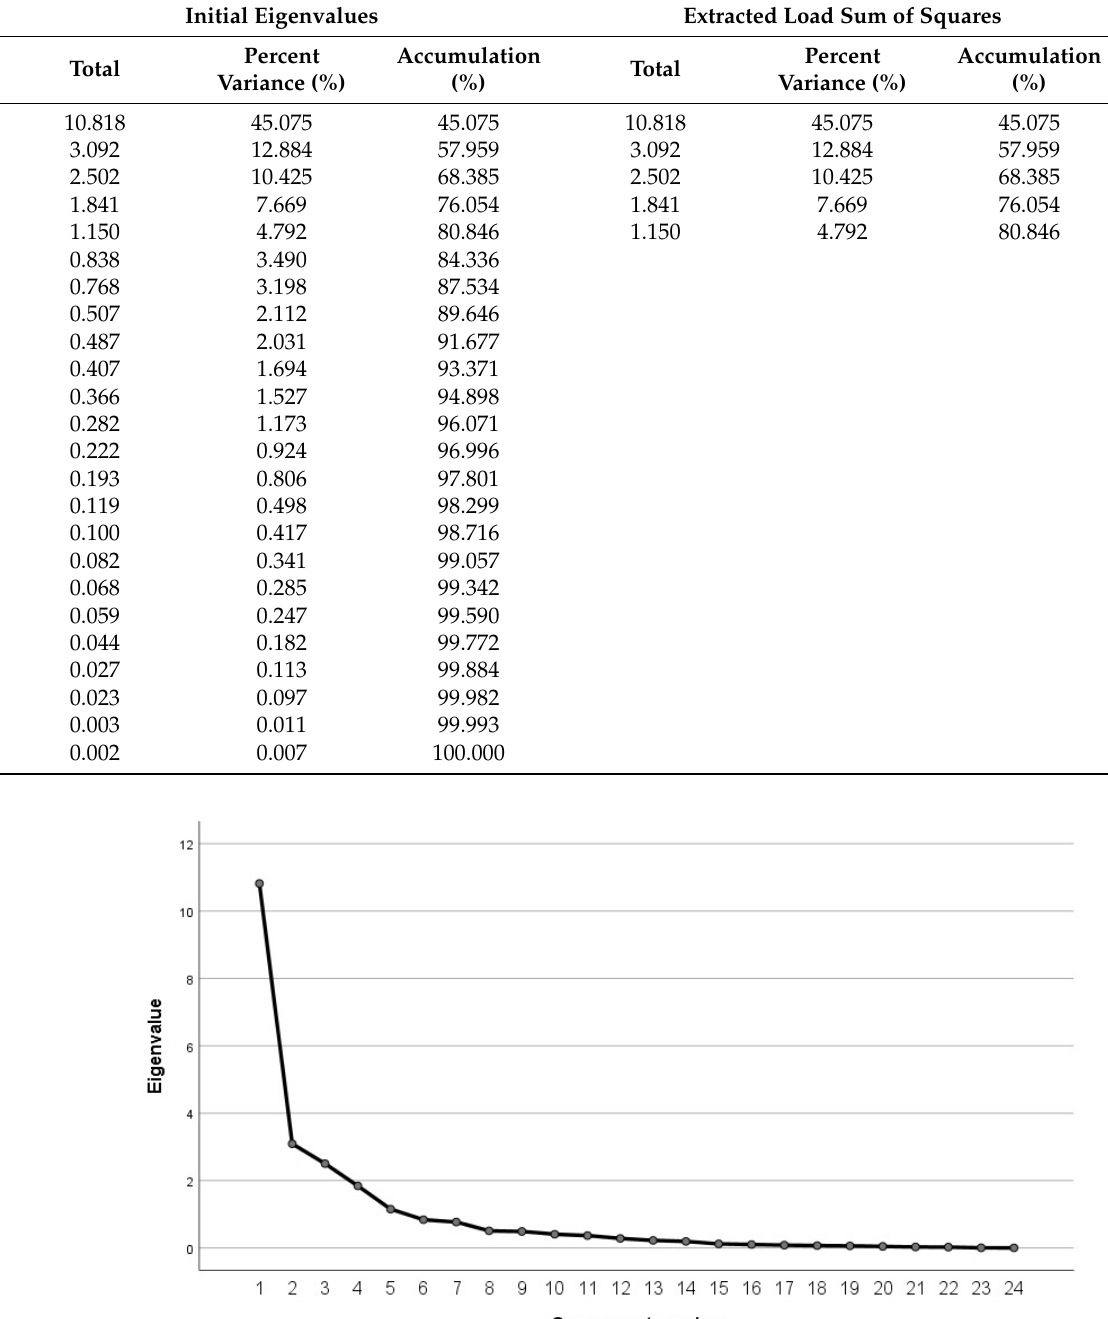
Table 4. Total explained variance of the vehicle driving experimental data.